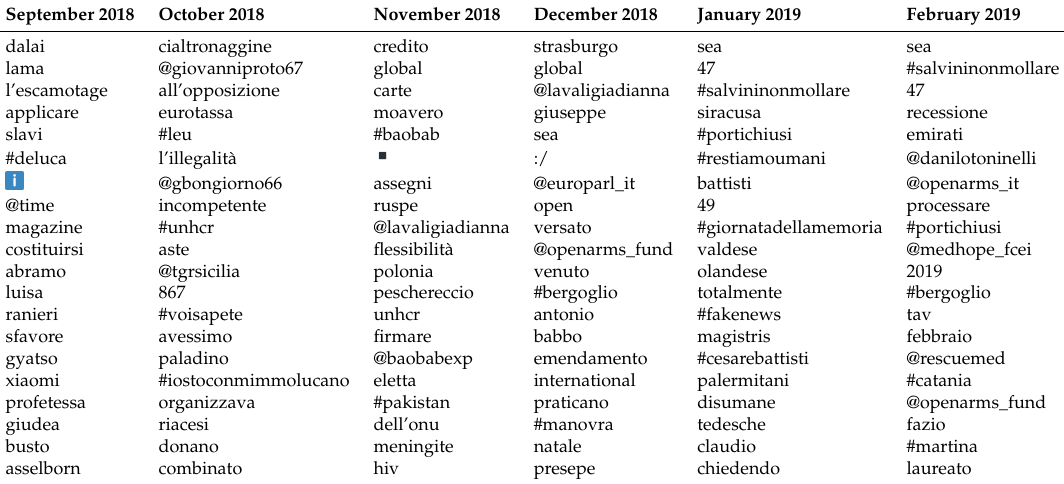
Table 10. Top 20 words by Weirdness Index in each test